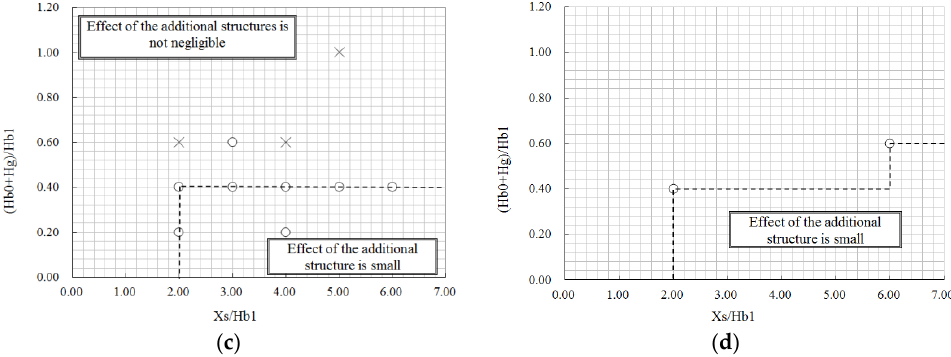
Figure 5. Effect of additional structure on effective stack height for four source heights. ( a ) accidental release at PWR site (Hs = 65 m, Hs/Hb1 = 1.0); ( b ) normal release at PWR site (Hs = 150 m, Hs/Hb1 = 2.3); ( c ) accidental release at BWR site (Hs = 120 m, Hs/Hb1 = 2.4); ( d ) normal release at BWR site (Hs = 180 m, Hs/Hb1 = 3.6).